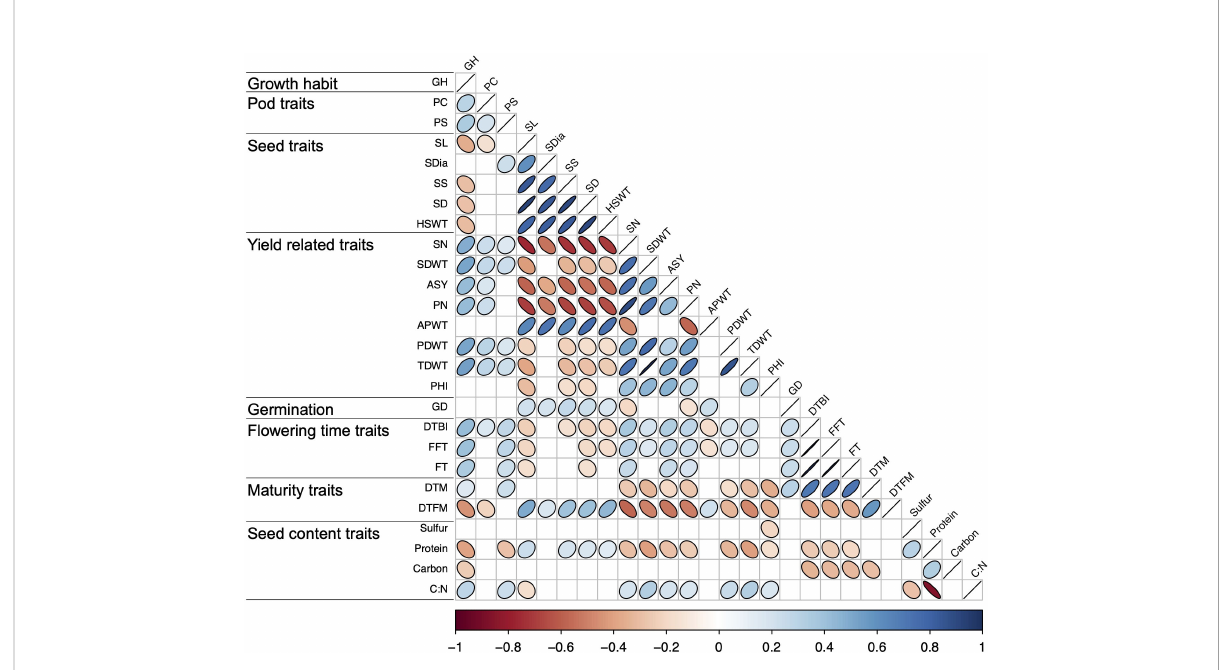
FIGURE 2 Correlation matrix for all phenotypic traits above r = 0.19. See Table 1 for trait abbreviations.